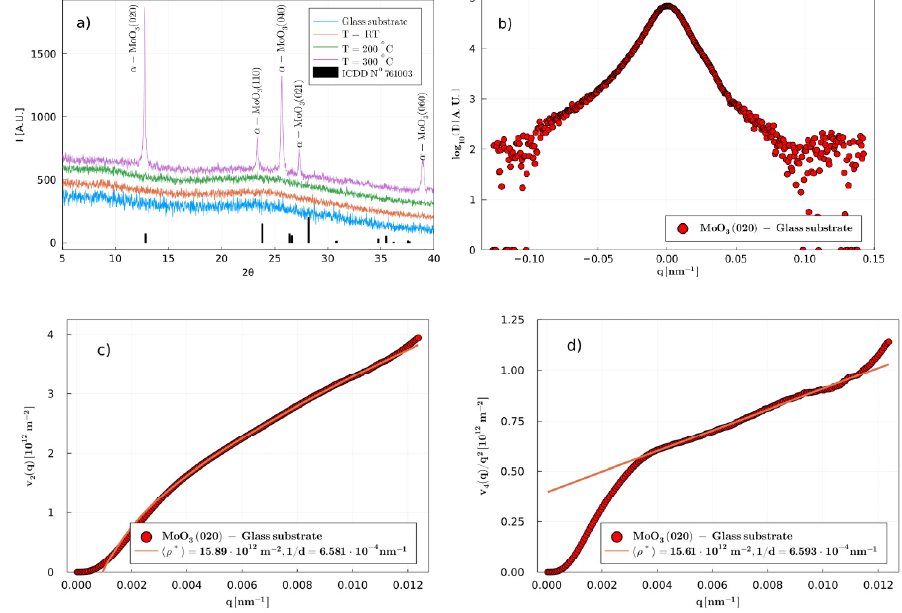
Figure 3. ( a ) XRD patterns of MoO 3 sputtered on glass substrate; ( b ) intensity distribution of the (200) Bragg-reflection; second-order ( c) and fourth-order ( d ) restricted moments.